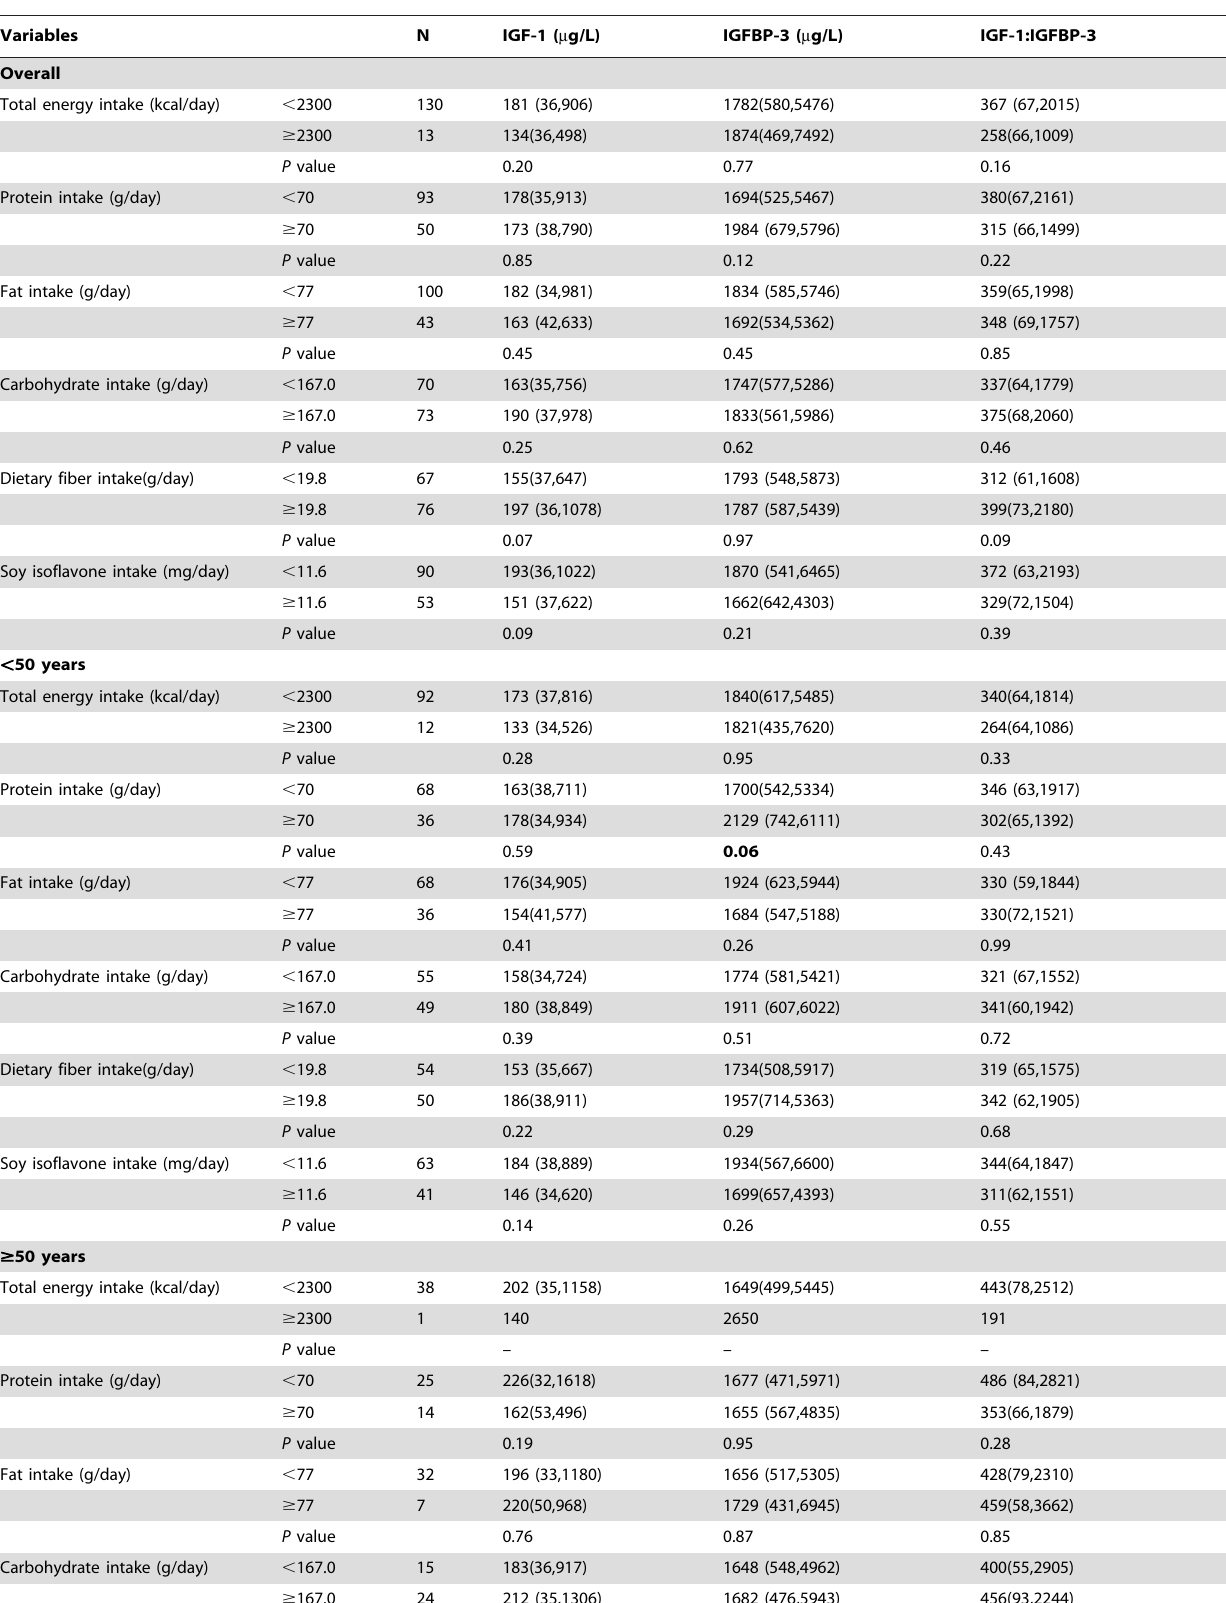
Table 2. Relationship between geometric mean (95% CI) of insulin-like growth factor component levels with dietary intake.